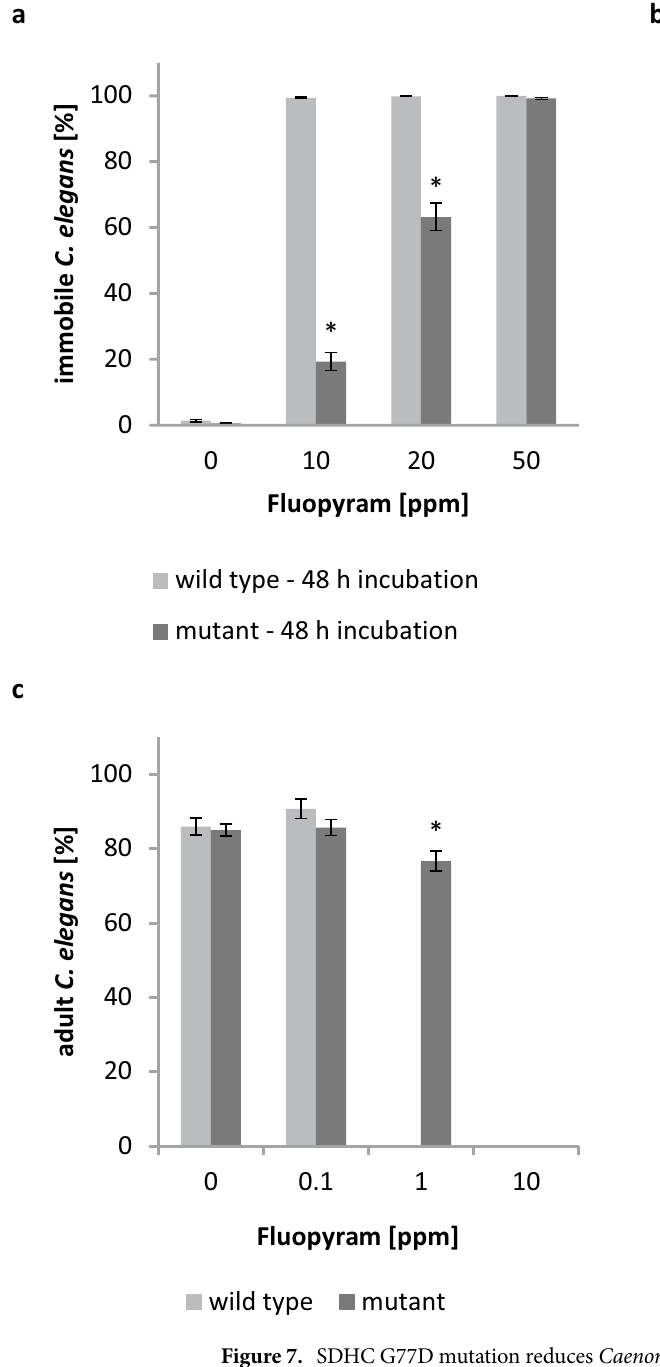
Figure 7. SDHC G77D mutation reduces Caenorhabditis elegans sensitivity against fluopyram. Synchronized C. elegans L1 were exposed to different concentrations of fluopyram or DMSO control for 48 h. Subsequently, nematodes were washed and incubated in water for 48 h. The number of immobile nematodes was counted at both of these time points ( a , b ). The number of nematodes that developed from L1 into adults was determined after permanent exposure to fluopyram or DMSO control for 6 days ( c ). Bars display mean ± SE of at least six ( a , b ) or three ( c ) independent biological replicates (n = 23–36 ( a , b ); n = 11–12 ( c )). Asterisks indicate significant differences between wild type and mutant at each condition according to Dunn’s method ( p <